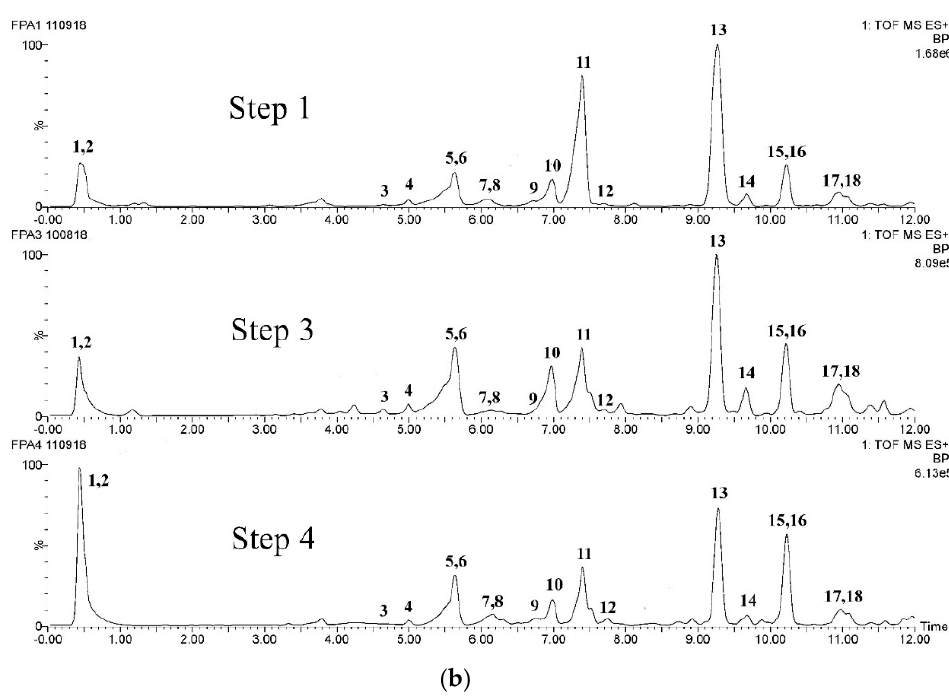
Figure 5. Base peak ion chromatograms of the leaf explants from Physalis angulata ( a ) with mass spectra extracted for several peaks of interest (red symbol indicates the molecular ion) ( b ) comparing steps 1 to 4 (the numbers in bold correspond to the compounds detailed in Table S1).